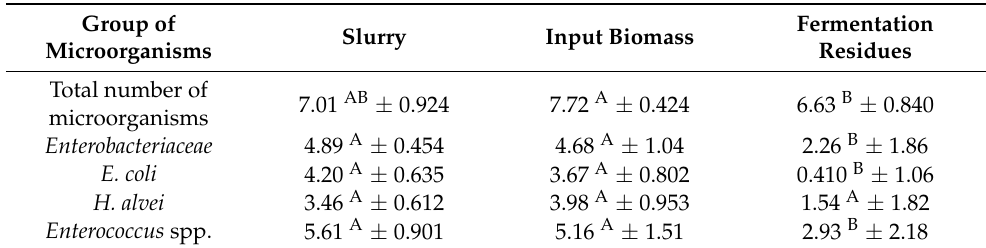
Table 6. The numbers of selected groups of microorganisms in the slurry, input biomass, and fermentation residues from the BP-M (log